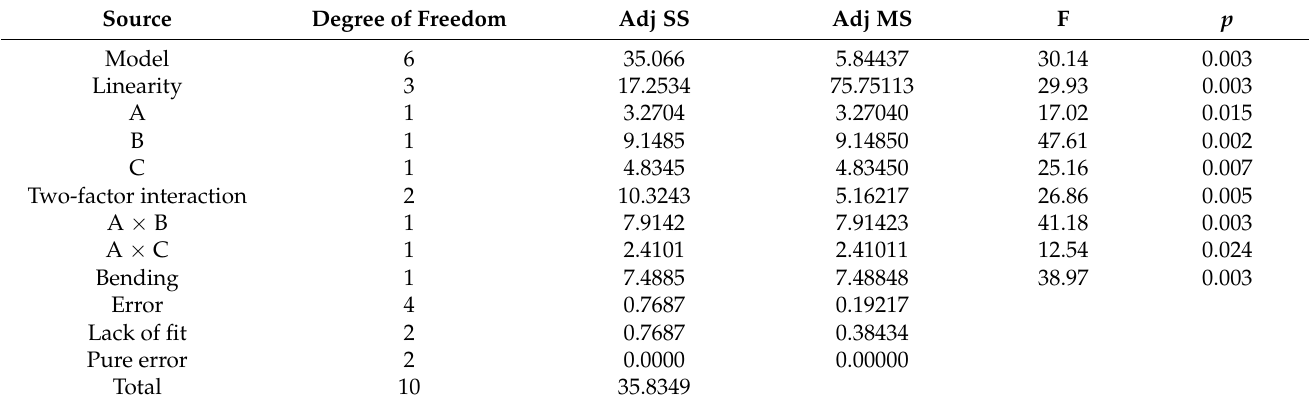
Table 7. Analysis of variance for the efficiency of the full-factorial experimental